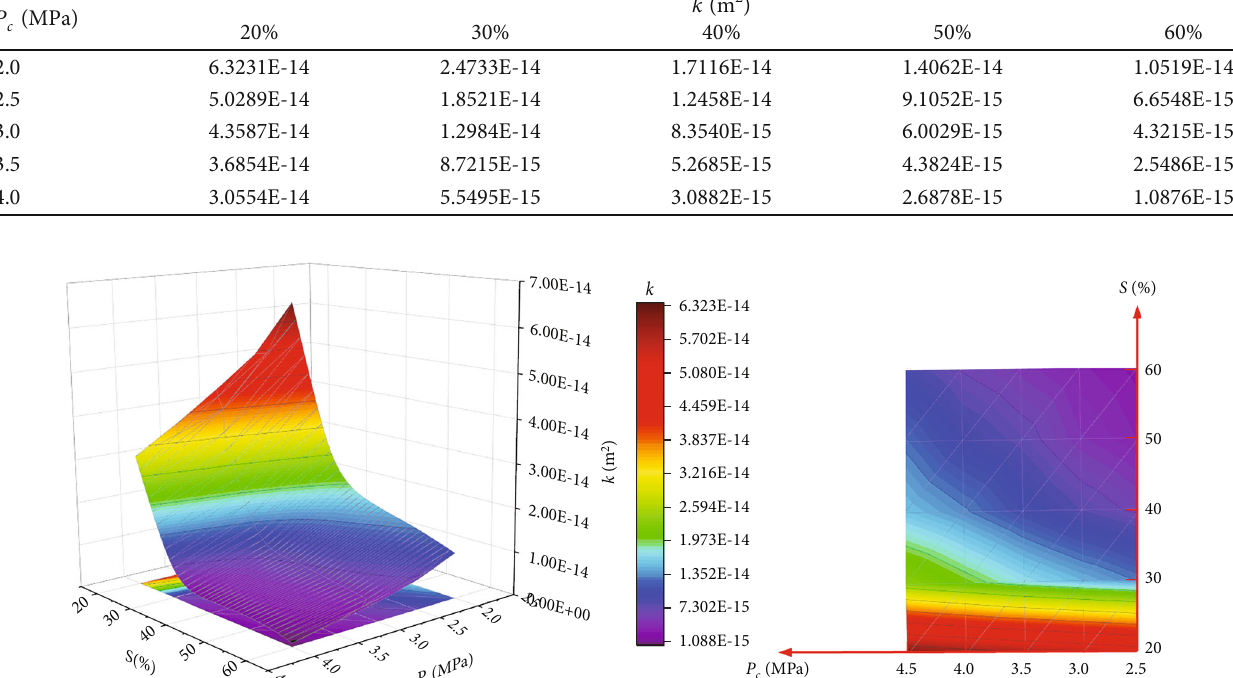
Table 6: Variation of permeability k with con fi ning pressure P P c (MPa)